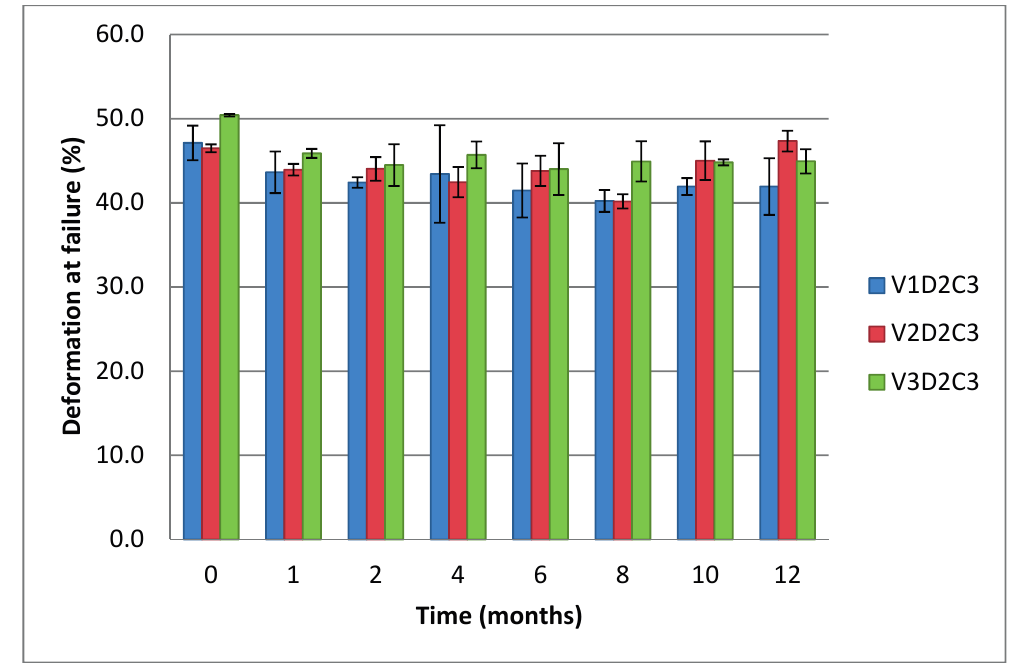
Figure 9. Comparison of deformation at failure over 12 months for cylindrical gels of (1% w / w ) chitosan of variable molecular weight at 3% theoretical DES